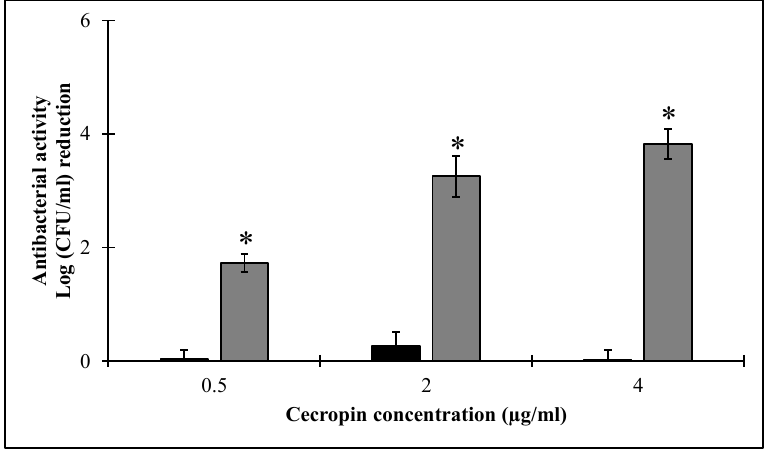
Figure 6. The antibacterial activity of HEWL (500 µ g/mL) in combination with cecropin A (grey bars) against stationary grown Salmonella enterica ATCC 35664. Black bars represent controls conducted by challenging bacterial cells to three ascending concentrations of cecropin A. LB exponentially grown bacterial cells were pelted, diluted to 10 6 CFU/mL and resuspended in 10 mM potassium phosphate buffer. The prepared culture was then subjected to a combination of 500 µg/mL HEWL with escalating doses of 0.5, 2 and 4 µ g/mL of cecropin A. Negative controls were performed using 10 mM potassium phosphate buffer instead of protein. Each value represents the mean ± standard deviation from three independent replicates. Asterisks represent the statistical differences from the values for cecropin A-treated cells (Student’s t test; * p <